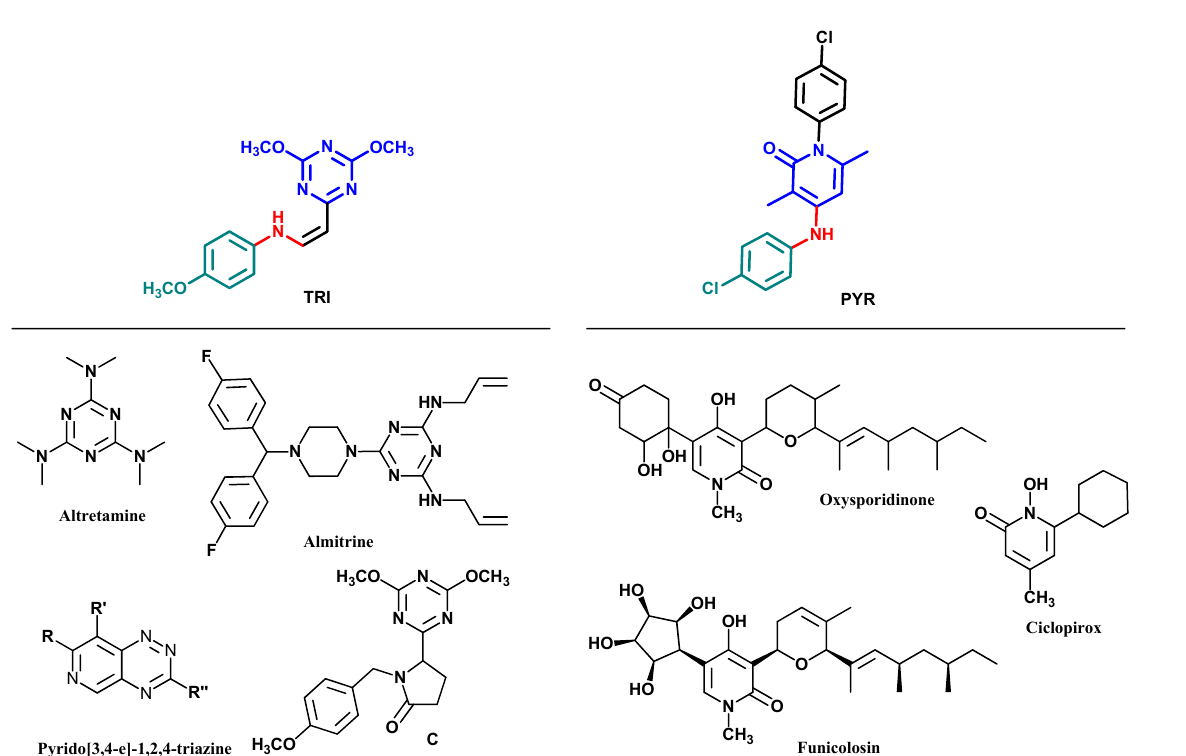
Figure 1. Active compounds TRI and PYR identified from initial screening; structure of compound C and reported active compounds similar to TRI and PYR.